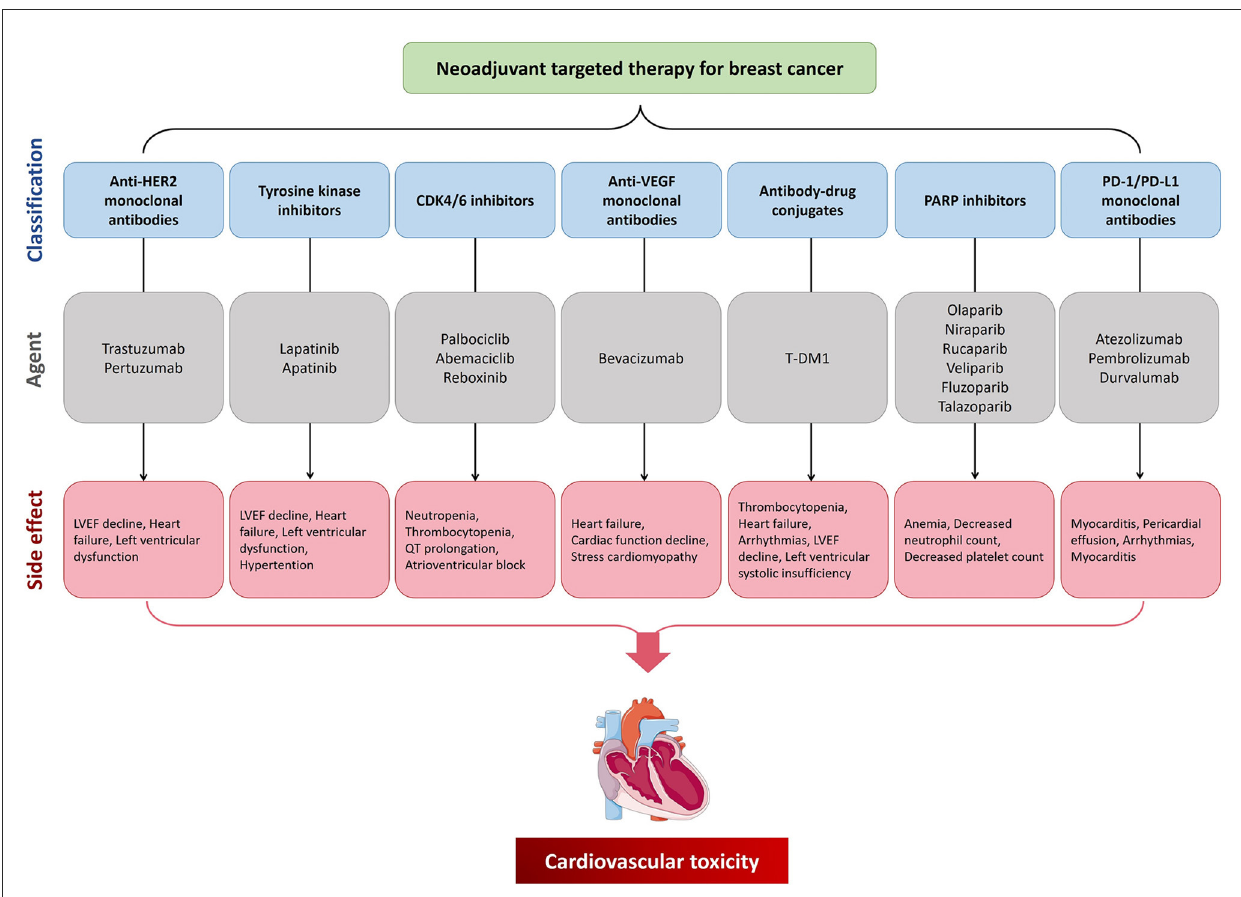
FIGURE1 The cardiovascular toxicity of neoadjuvant targeting treatment for breast cancer. CDK4/6, cyclin-dependent kinases 4/6; HER2, human epidermal growth factor receptor 2; LVEF, left ventricular ejection fraction; PARP, poly adenosine diphosphate ribose polymerase; PD-1, programmed cell death protein 1; PD-L1, programmed cell death 1 ligand 1; VEGF, vascular endothelial growth